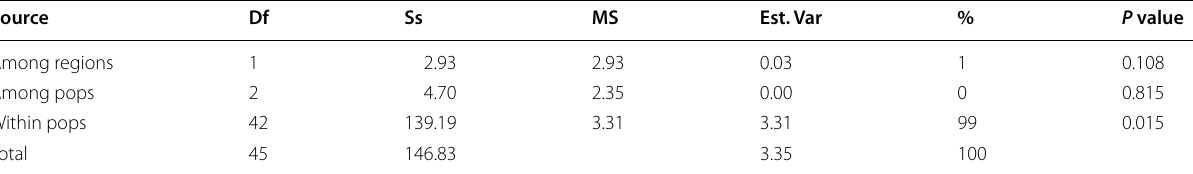
Table 4 Analysis of molecular variance (AMOVA) for 38 bradyrhizobia isolates based on restriction digest of 16S rRNA using Hae III, Msp I, and EcoR I